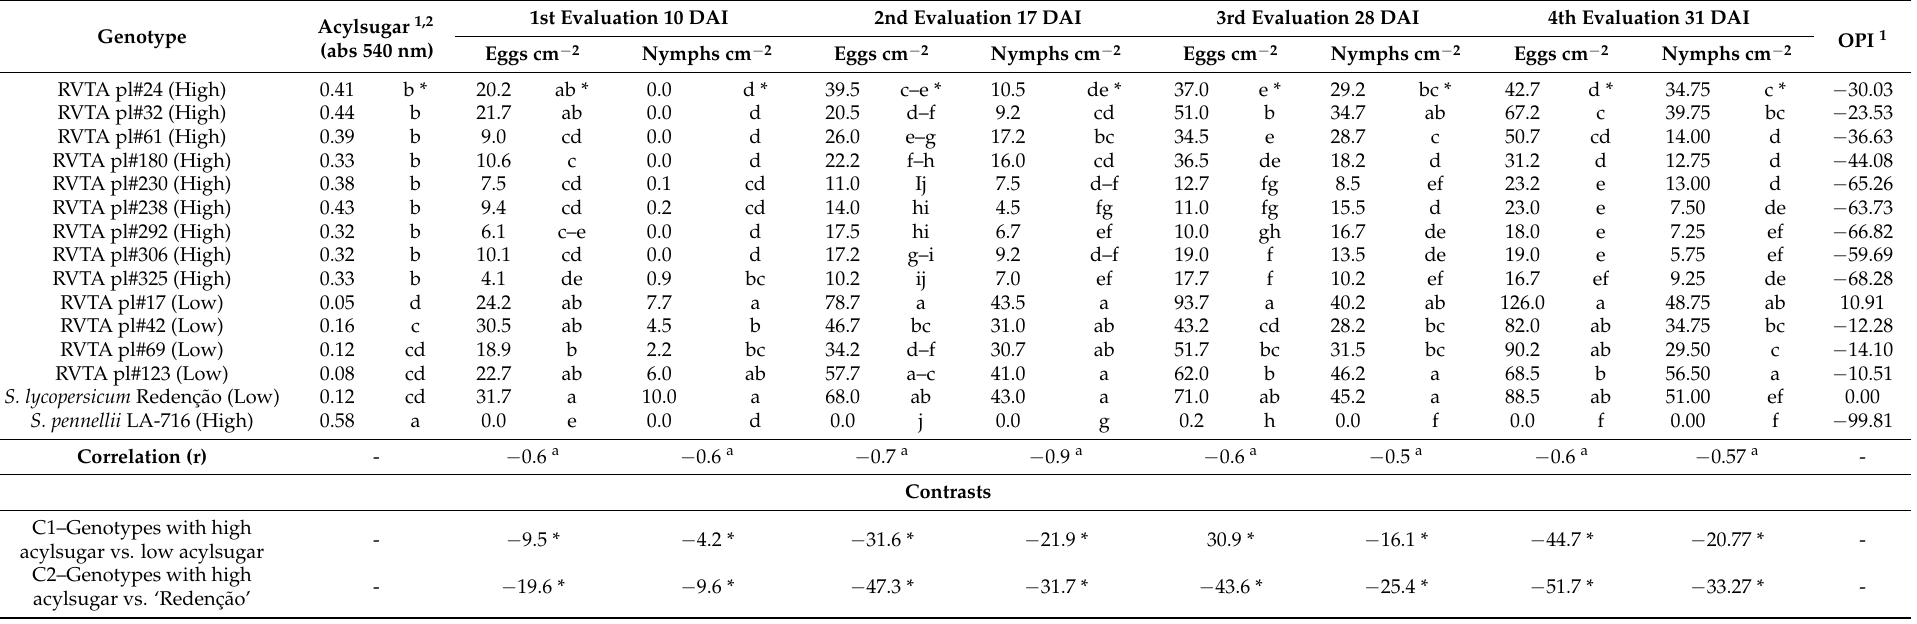
Table 7. Acylsugar content (based on absorbance at 540 nm) and average number of eggs and nymphs at 7, 14, 21, and 28 days after infestation (DAI) of whitefly in F 2 BC 3 tomato genotypes and oviposition preference index